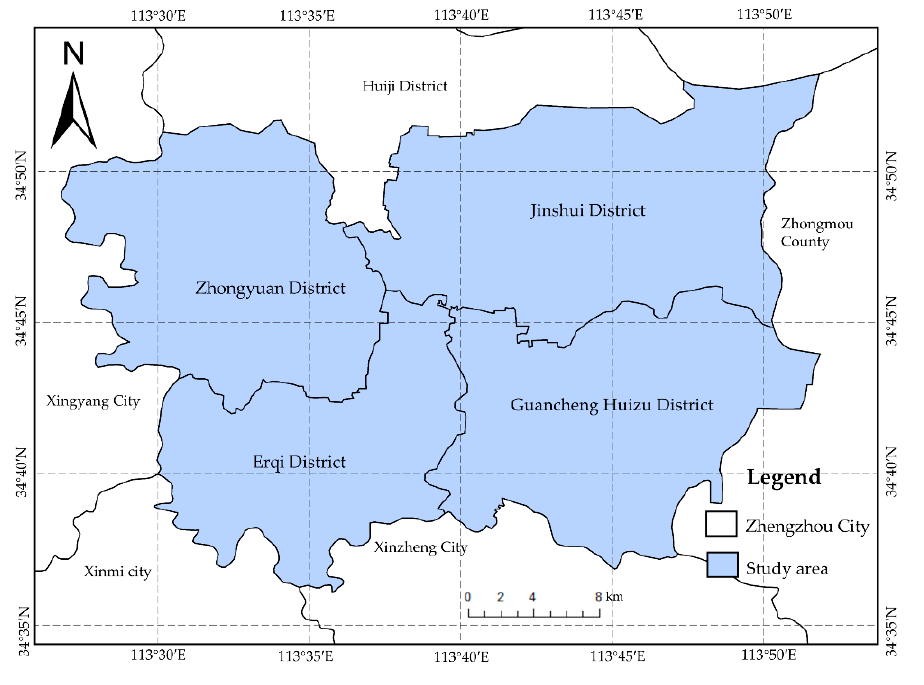
Figure 2. Core areas of Zhengzhou City. Table 1. Data used in this